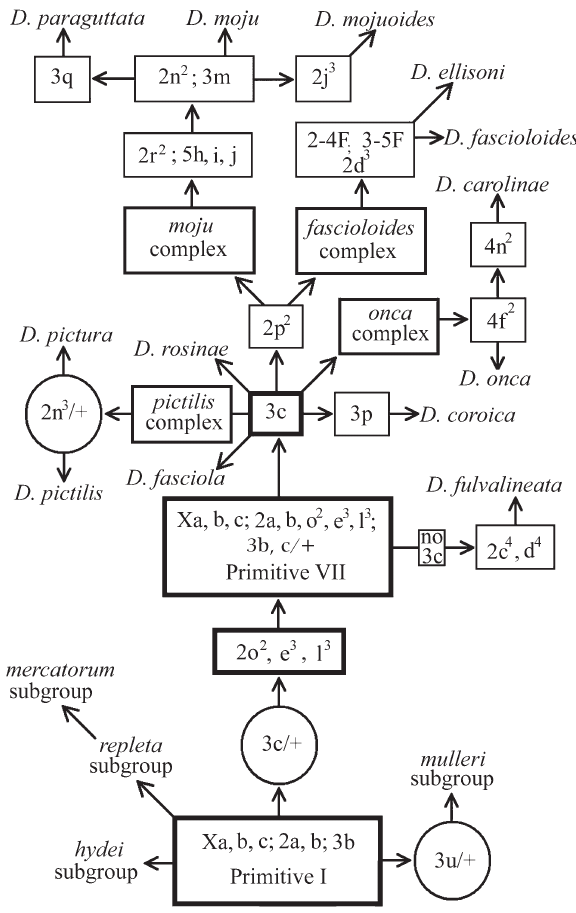
Figure 1 - Diagram illustrating the phylogenetic relationships among some species within the fasciola subgroup and between the subgroups in the repleta group (modified from Wasserman, 1992 and Diniz and Sene,